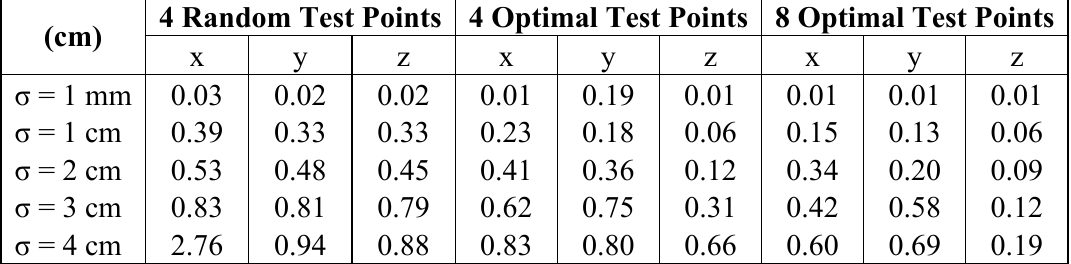
Table 2. Average error in the localization of beacons (in